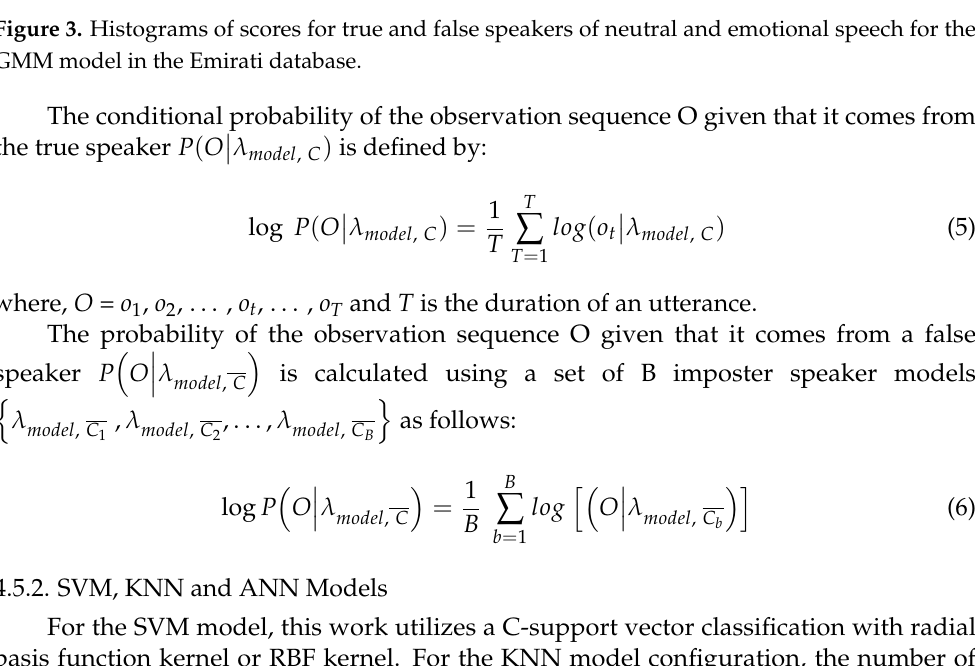
Figure 3. Histograms of scores for true and false speakers of neutral and emotional speech for the GMM model in the Emirati database.